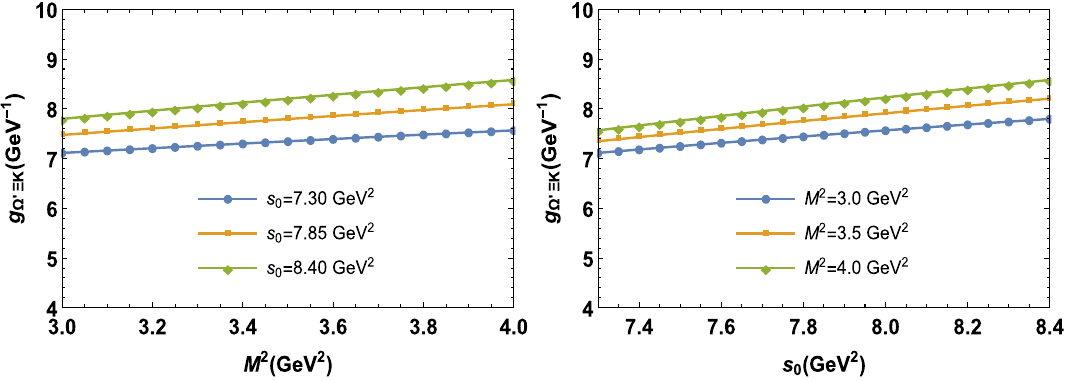
Fig. 2 Left: The coupling constant g (cid:2) (cid:4) (cid:3) K for the transition of the radially excited (cid:2) baryon vs Borel parameter M 2 for the structure / qq μ . Right: The coupling constant g (cid:2) (cid:4) (cid:3) K for the transition of the radially excited (cid:2) baryon vs threshold parameter s 0 for the structure / qq μ Table 2 Sum rules predictions for the strong coupling constants and widths corresponding to the decays of the orbitally and radially excited (cid:2) states to (cid:3) and K using different Lorentz structures Structure